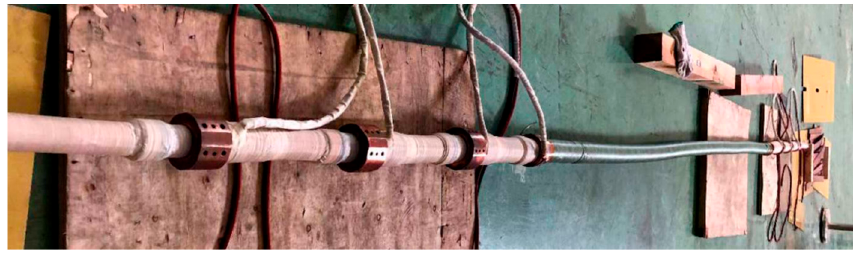
Figure 10. The developed 10 kV cable prototype. Table 1. Specifications of the cable conductor.